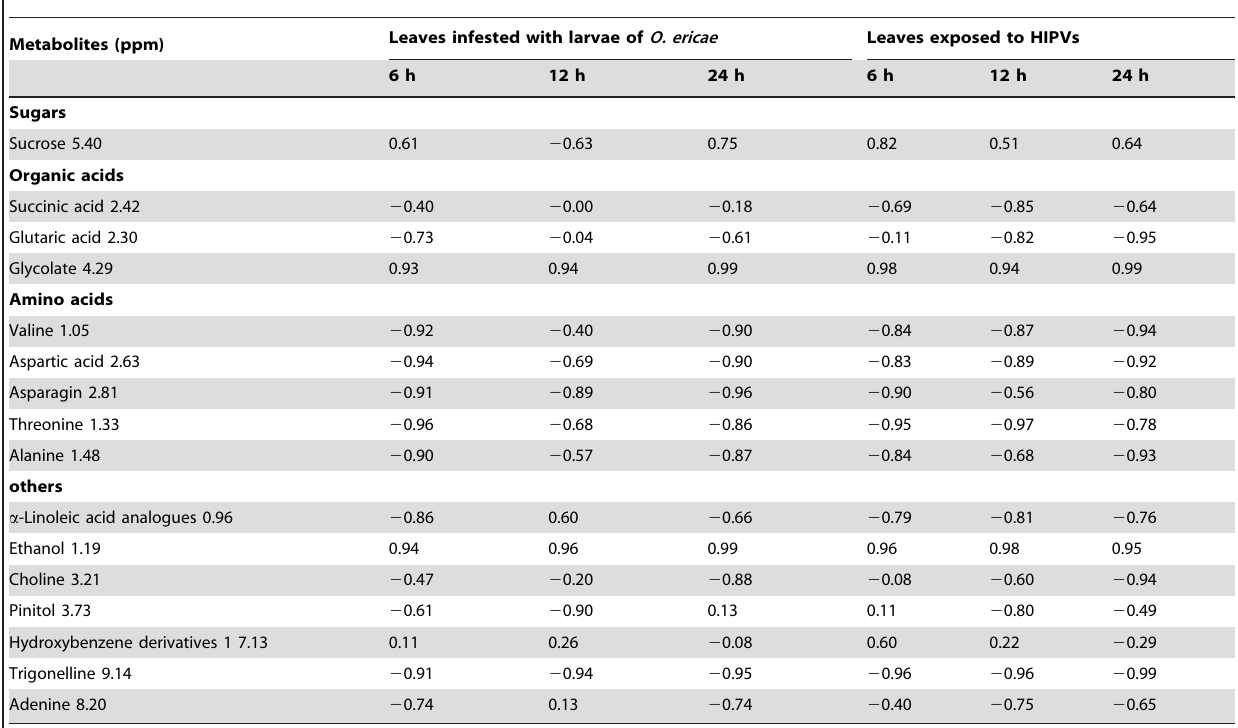
Table 2. Correlation coefficients of significantly changed metabolites induced by herbivore or HIPVs exposure.